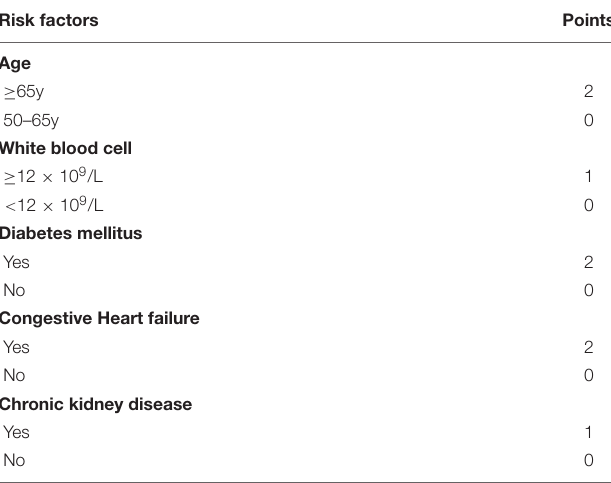
TABLE 3 | Scores points for the independent variables.